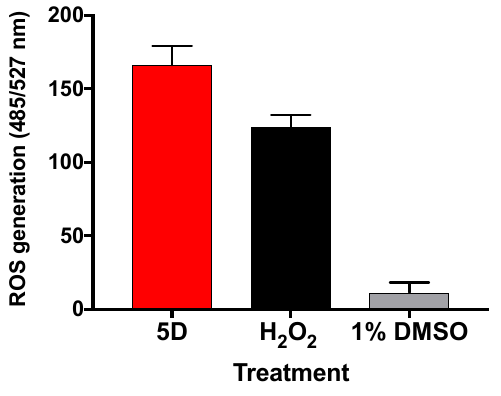
Figure 6. Generation of reactive oxygen species in L. major treated for 31 h with 5D at 0.90 µM (EC 50 ). Values shown are the mean and standard error of five different replicates minus basal fluorescence.